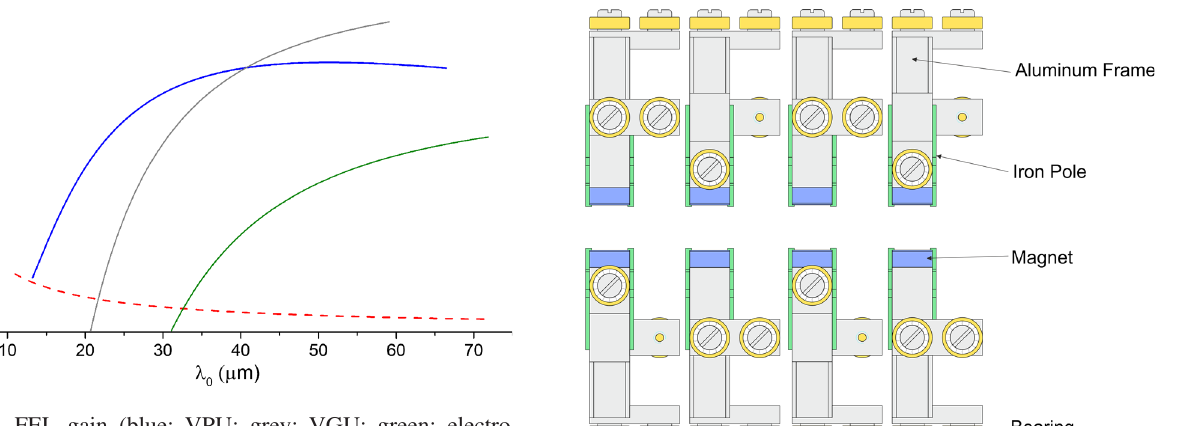
FIG. 18. FEL gain (blue: VPU; grey: VGU; green: electro- magnetic undulator) and optical cavity losses (red dashed) for different radiation wavelengths. FIG. 19. Side view of units in undulator (maximum period).